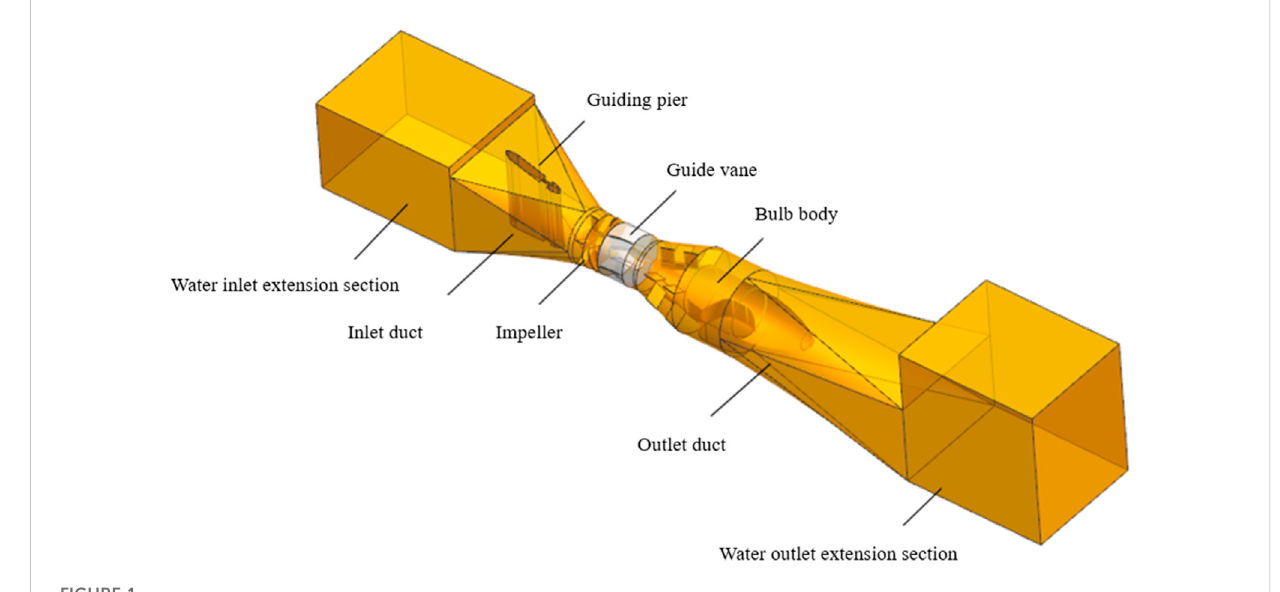
Flow channel structure of bulb tubular pump device.